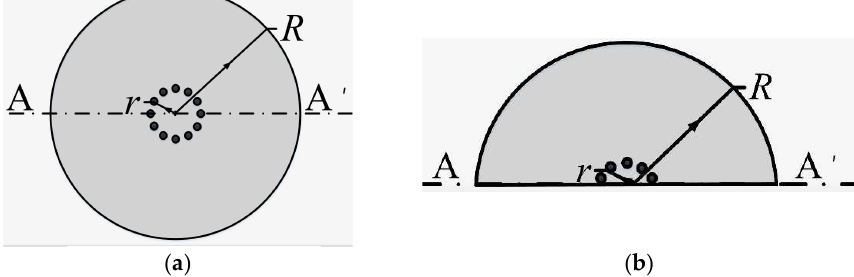
Figure 1. Geometric structures of the short-circuited circular and semicircular patch resonators. ( a ) Circular patch resonator; ( b ) semicircular patch